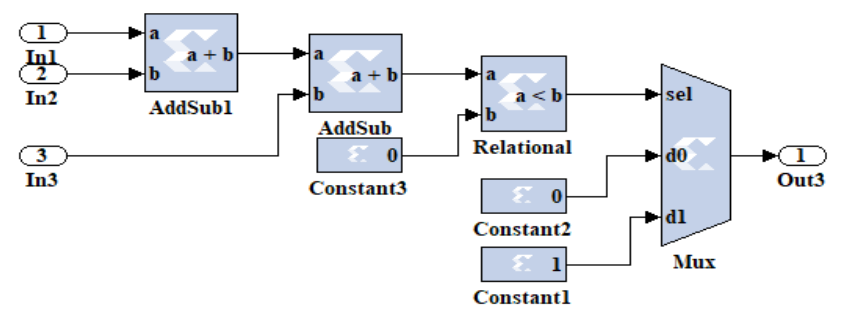
Fig. 12. Column 12's vertical step